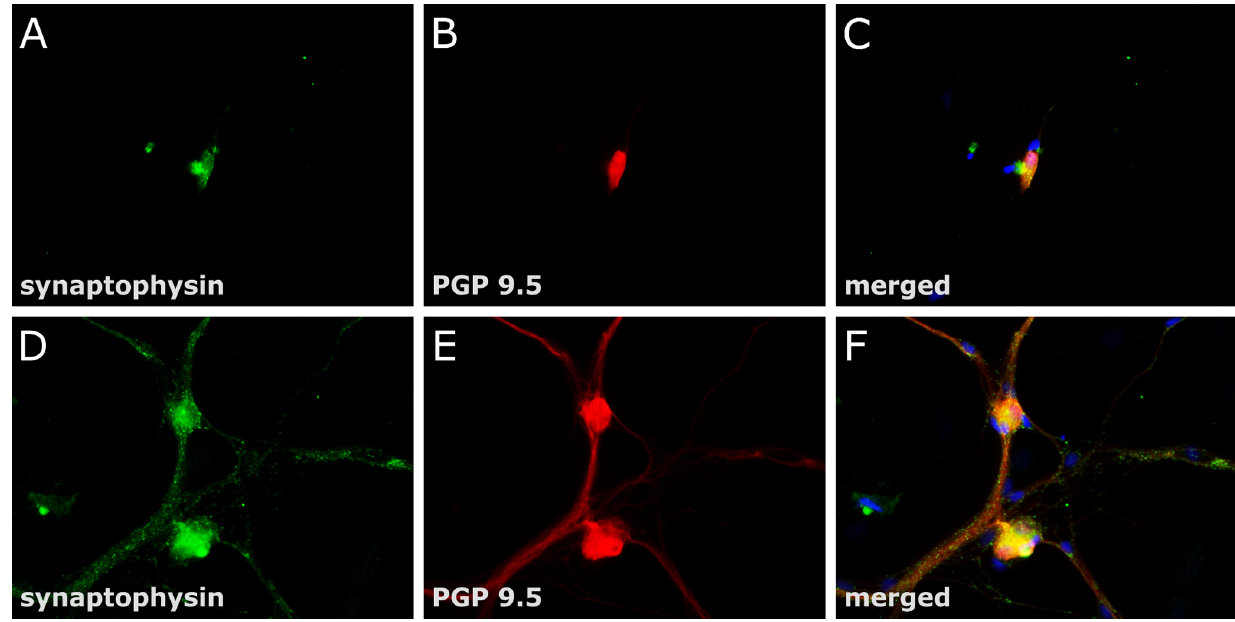
Figure 6. Synaptophysin immunoreactivity of enteric nerve cell cultures after GDNF treatment. Rat enteric nerve cells were cultured for 3 week without (A-C) or with 50 ng/ml GDNF (D-F). Dual label immunocytochemistry for synaptophysin (green, A, D) and the pan-neuronal marker PGP 9.5 (B, E) was performed. In the merged pictures (C, F) cellular nuclei are stained with DAPI (blue). Cell cultures treated with GDNF display punctuate and granular synaptophysin immunoreactivity along ramifying nerve fibers most likely resembling accumulated synaptic vesicles, whereas in untreated cell cultures immunoreactive signals were confined to neuronal somata. Magnification: 40 6 .